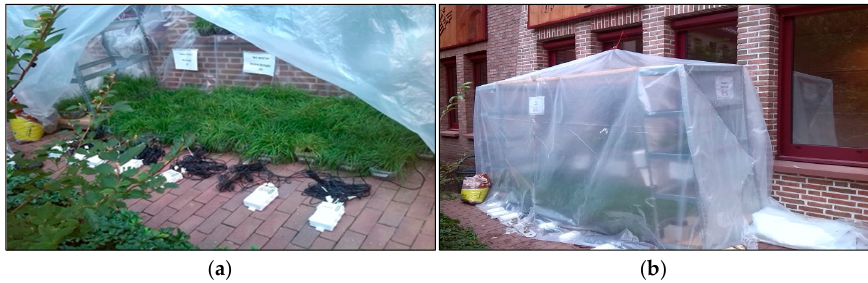
Figure 1. Experimental setup. ( a ) Plant pots, soil moisture sensors and data loggers to record soil moisture status continuously; ( b ) Closed greenhouse during the night and rainfall events.